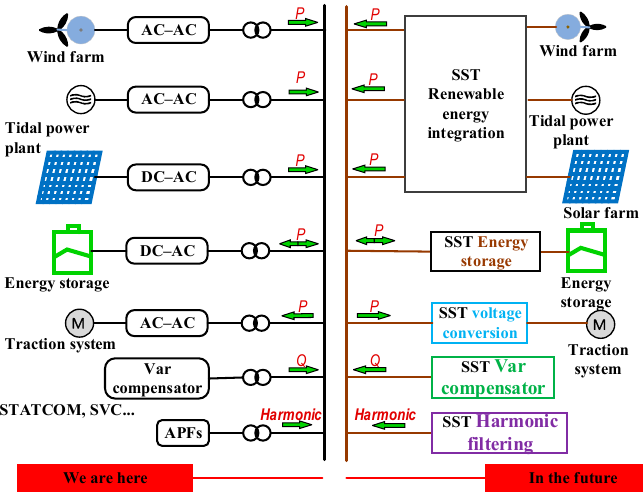
Figure 3. Potential application of SST technology in a future distribution system.